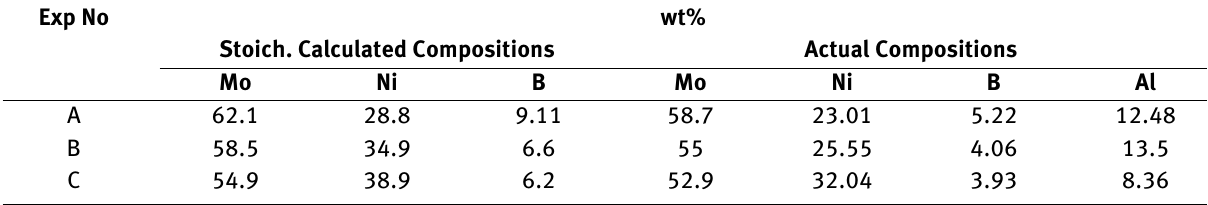
Table 3: The EDS measured elemental compositions for crystalline phases shown in Figures 1(a), (b), and (c)